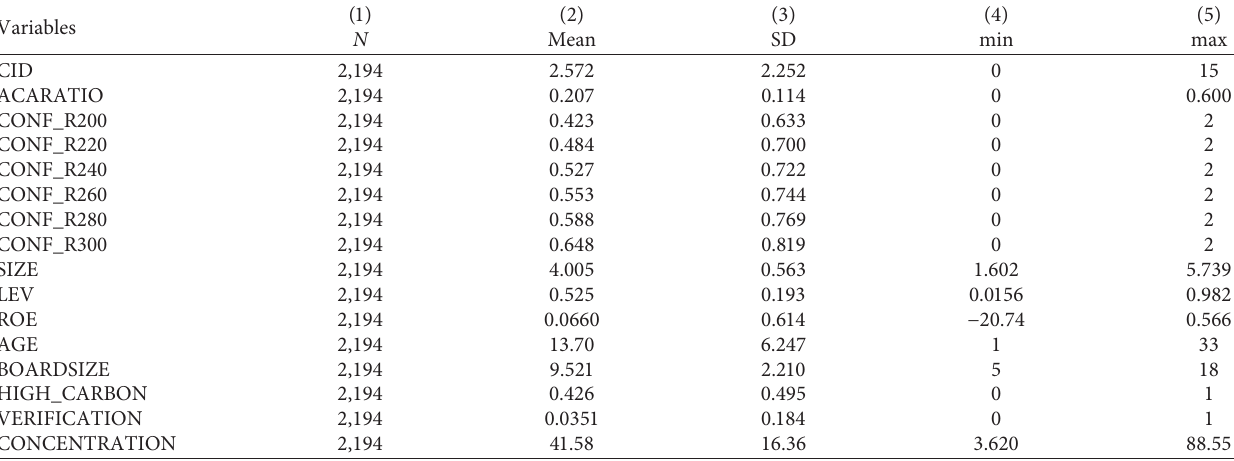
Table 3: Descriptive